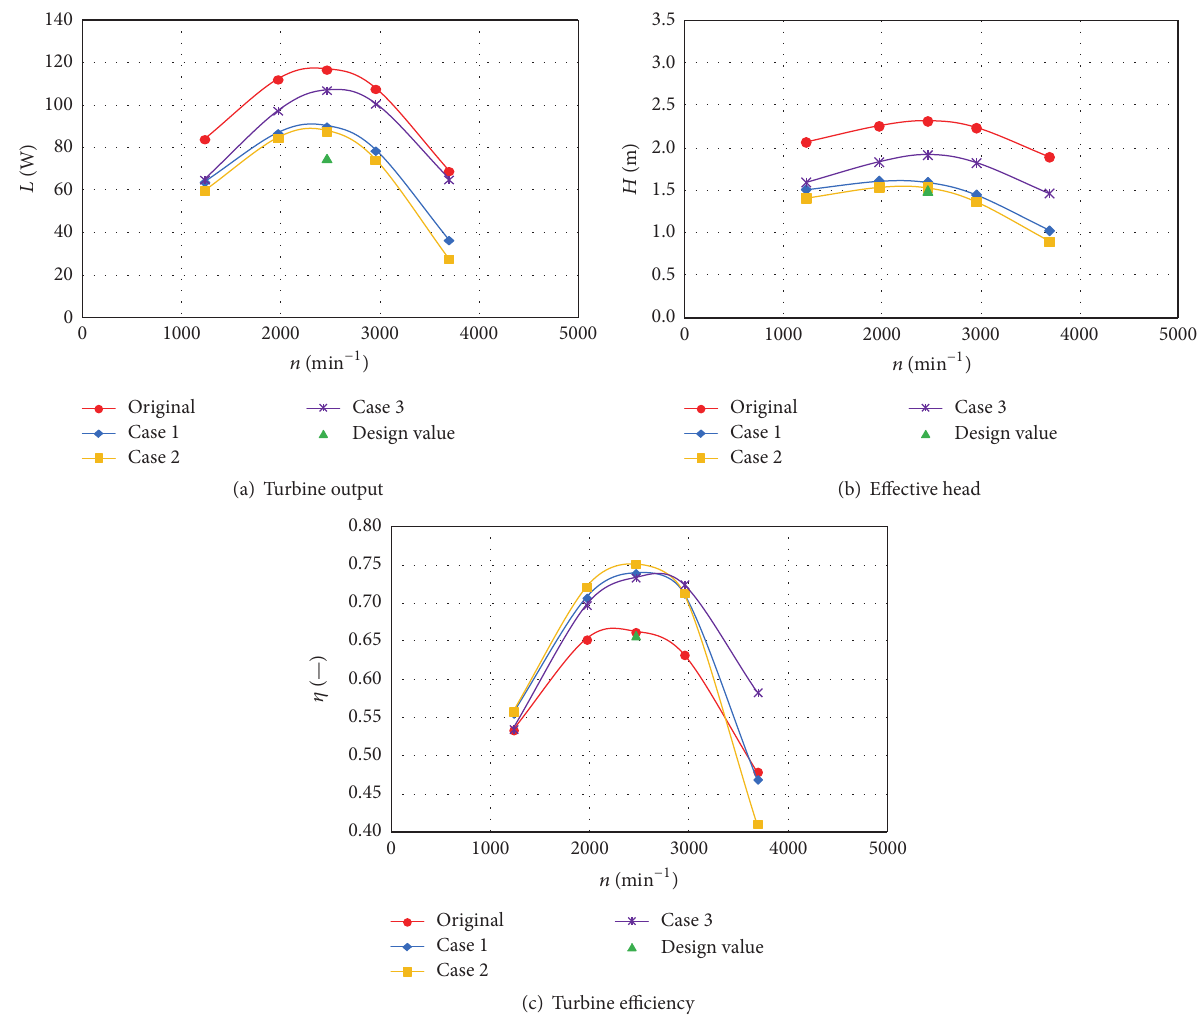
Figure 8: Turbine performances